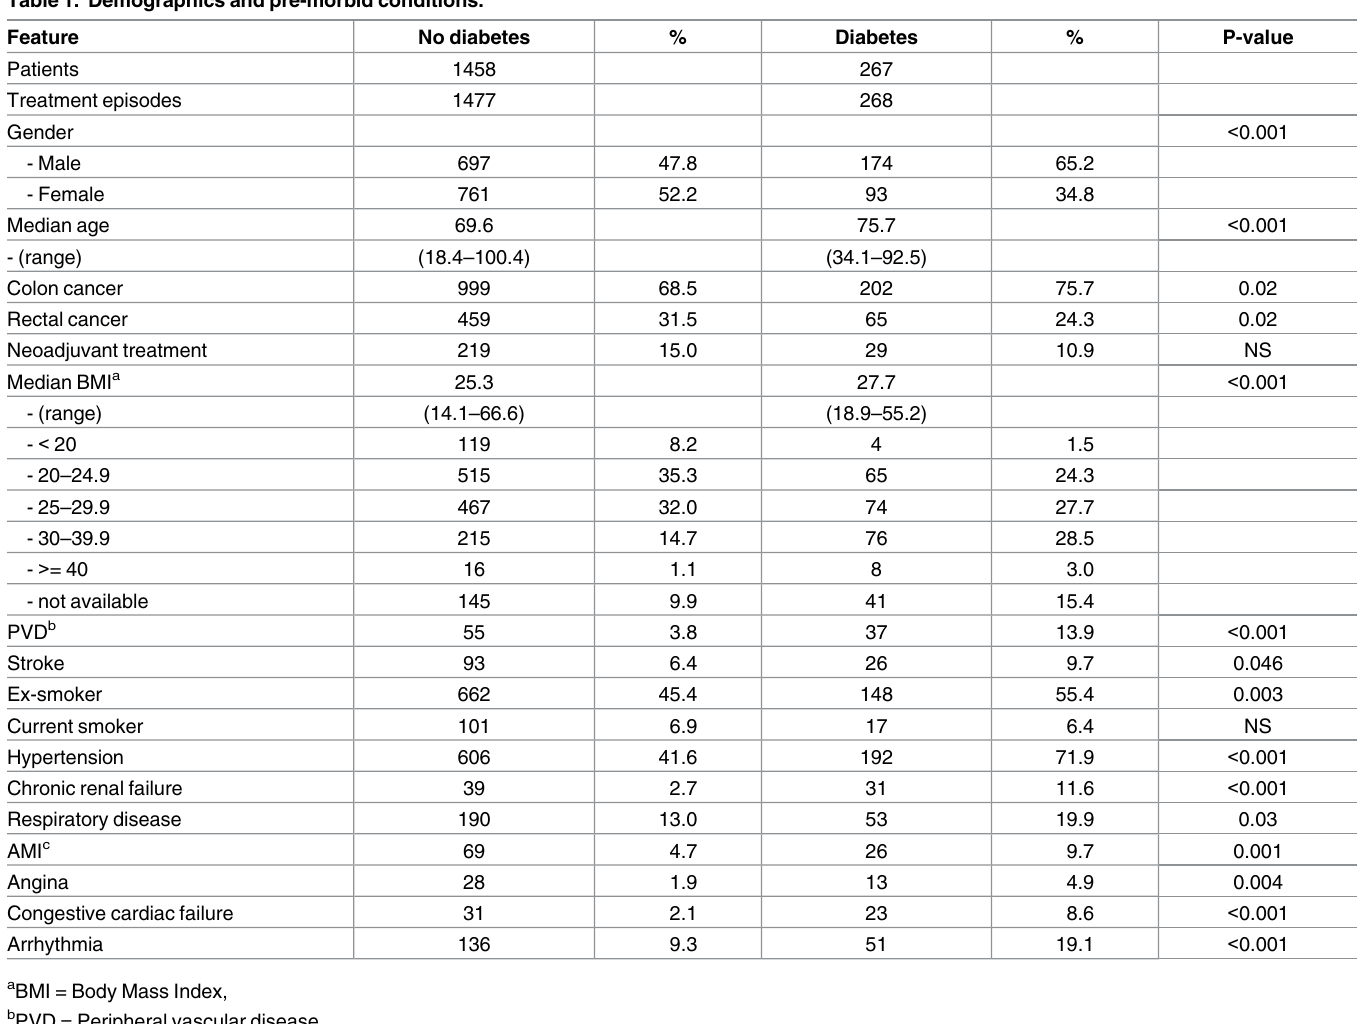
Table 1. Demographics and pre-morbid